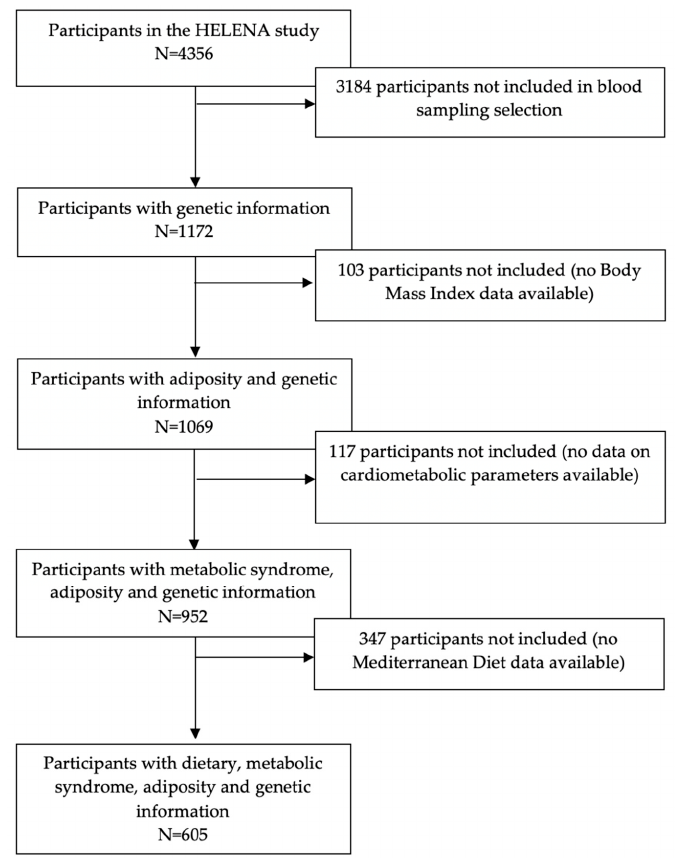
Figure 1. Flow chart of the sample selection process.